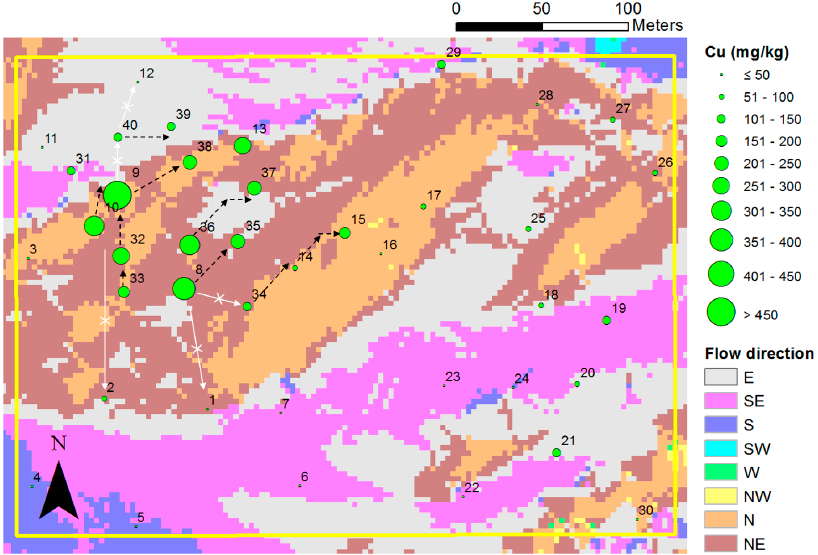
Figure 10. Hydrological analysis for the evaluation of the effect of flow direction of surface runoff on the copper dispersion.